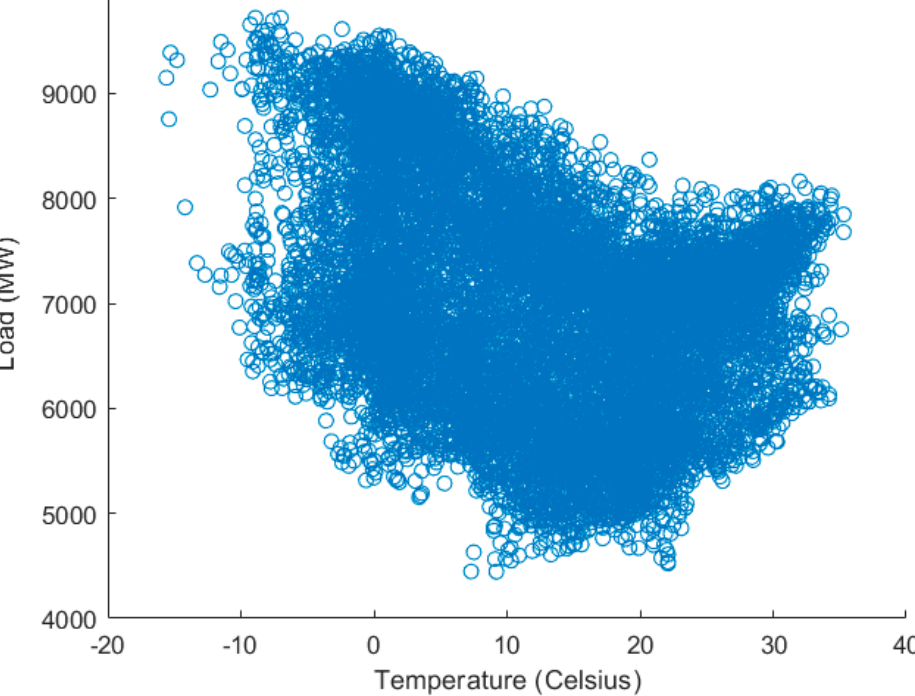
Figure 3. Temperature influence on energy